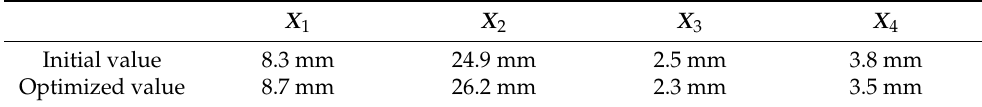
Table 6. Comparison of design variables before and after